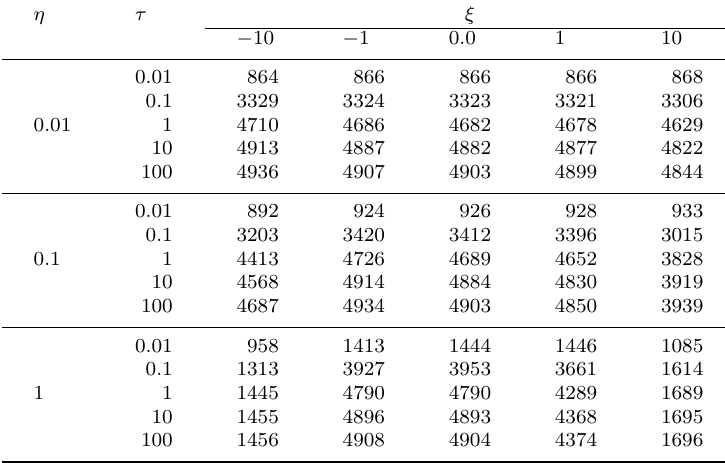
Table 3. The number of iterations for various τ